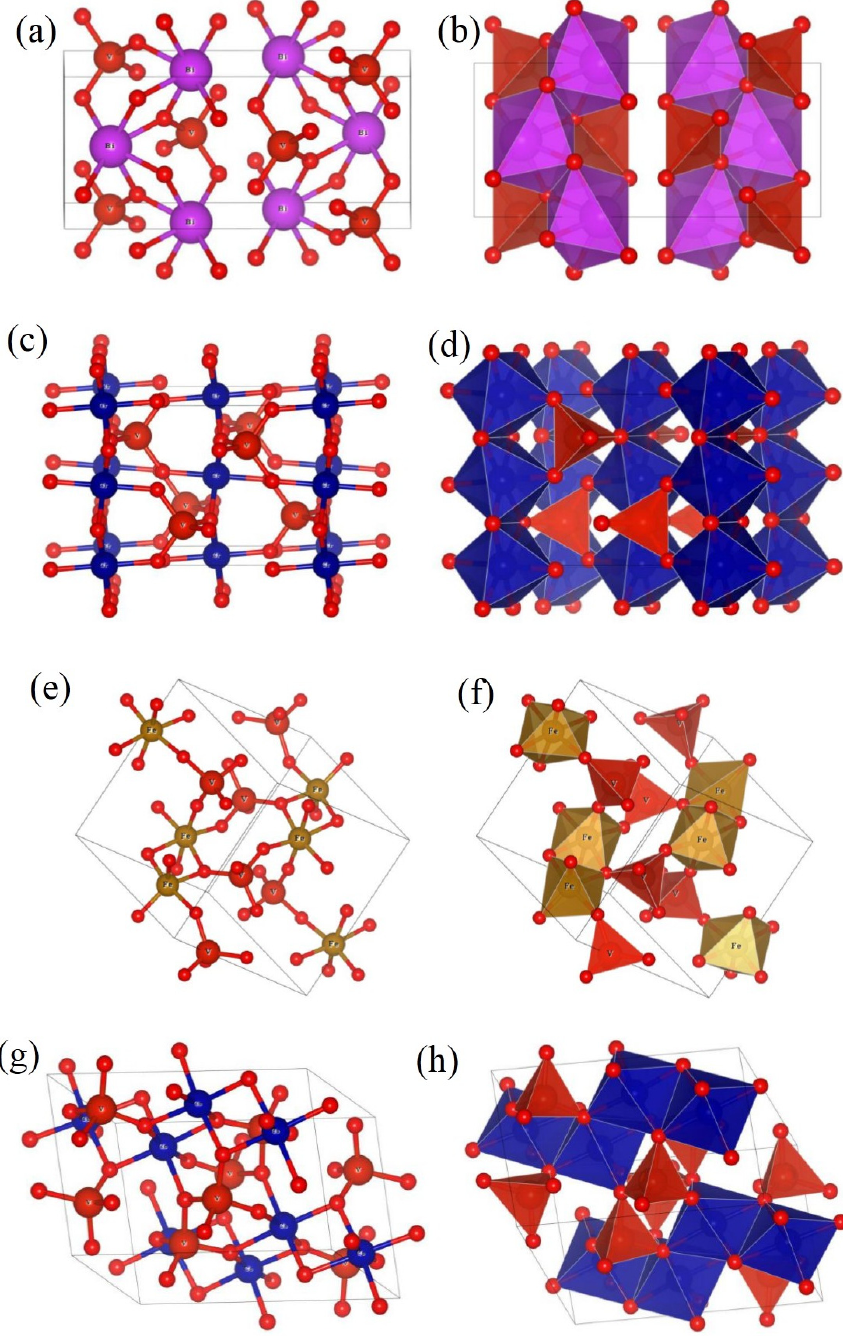
Figure 2. Crystal structure of ( a , b ) BiVO 4 , ( c , d ) CrVO 4 , ( e , f ) FeVO 4 , and ( g , h ) Co 2 V 2 O 7 .